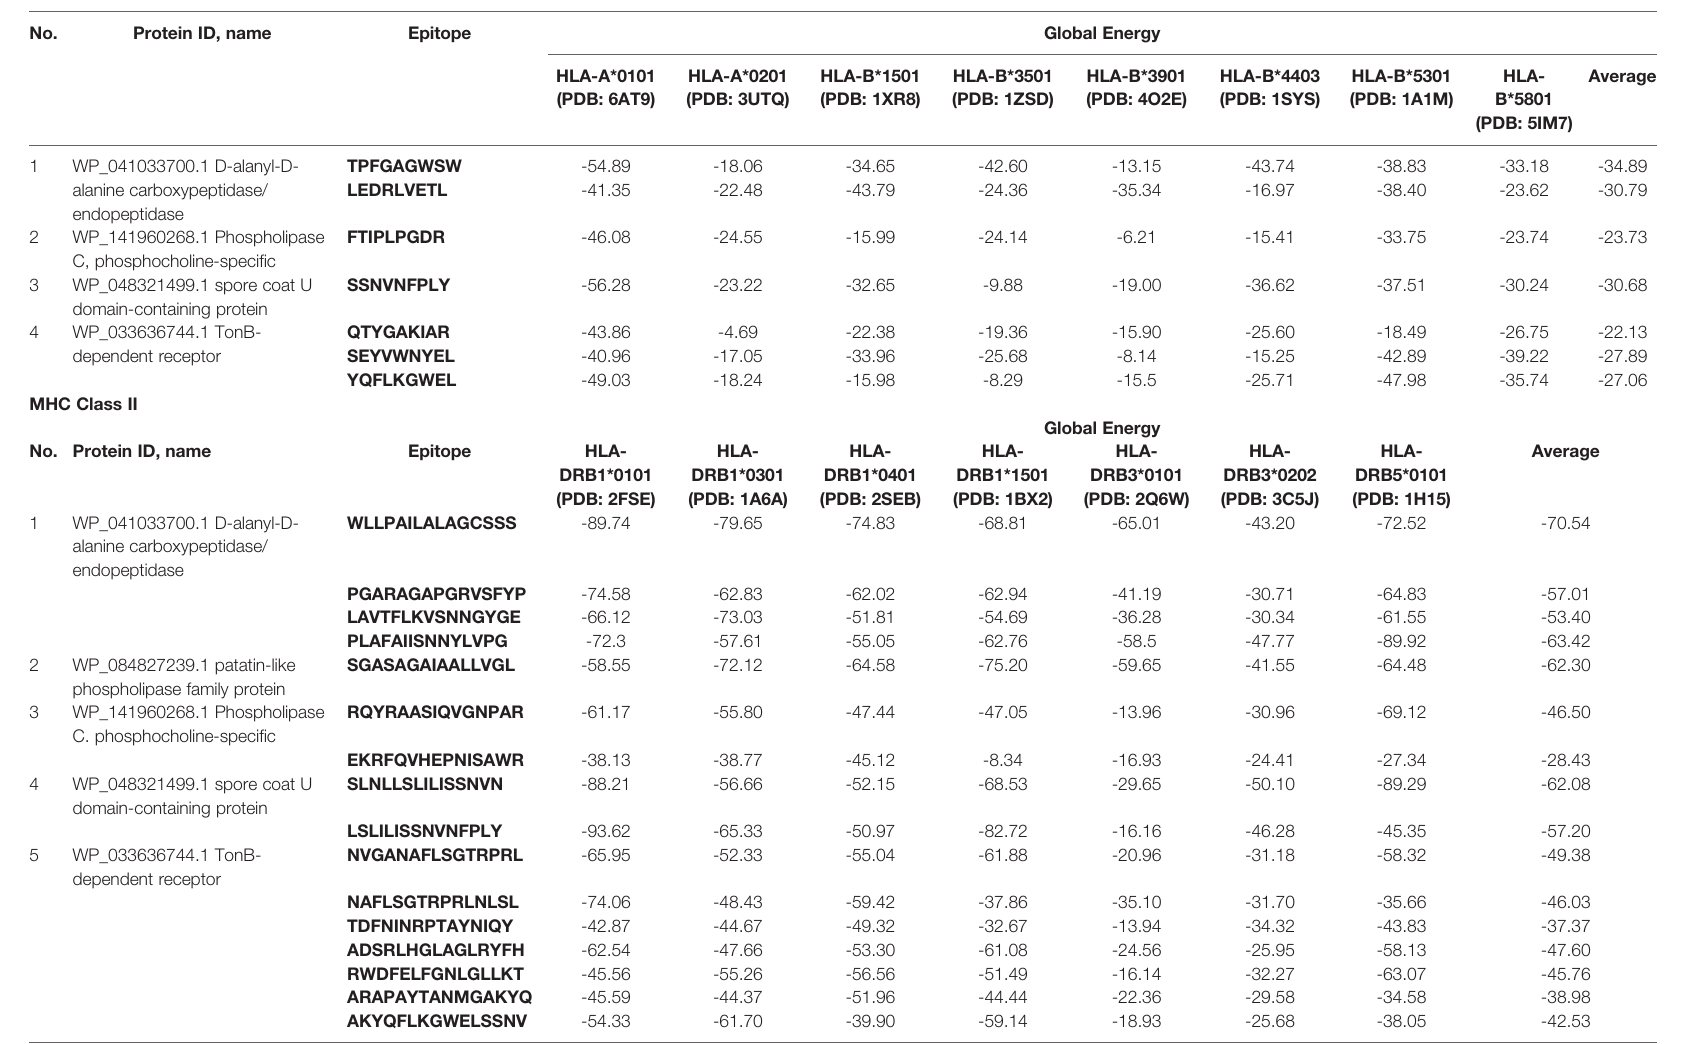
TABLE 5 | Molecular docking of epitopes with